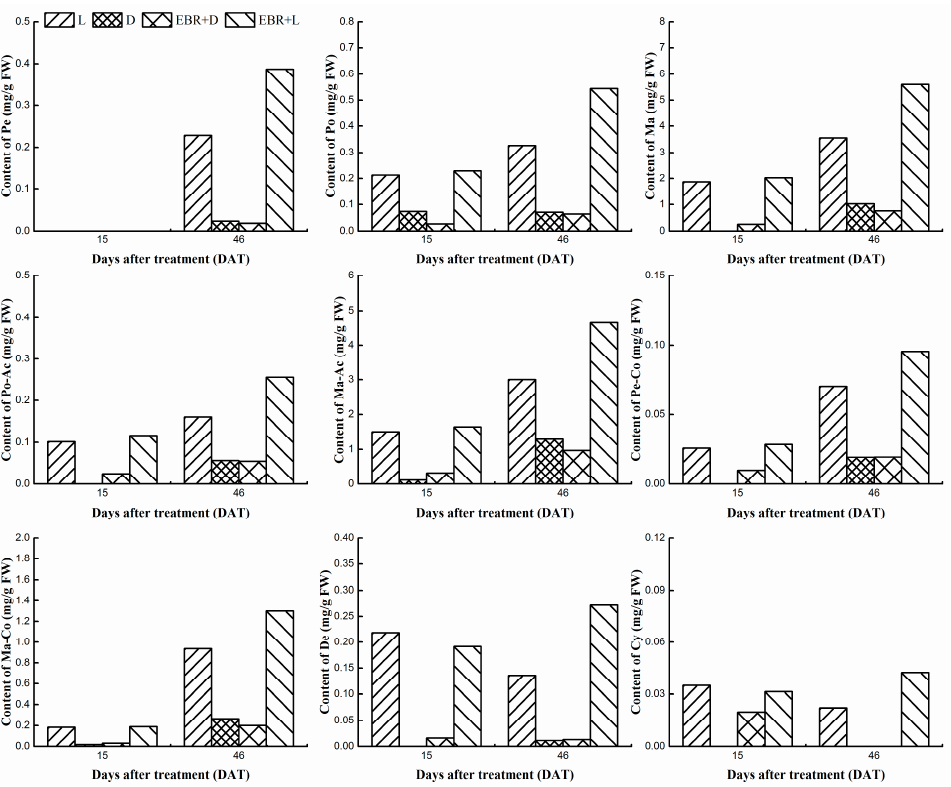
Figure 4. Individual anthocyanins content identified in Cabernet Sauvignon skins in 15 DAT and 46